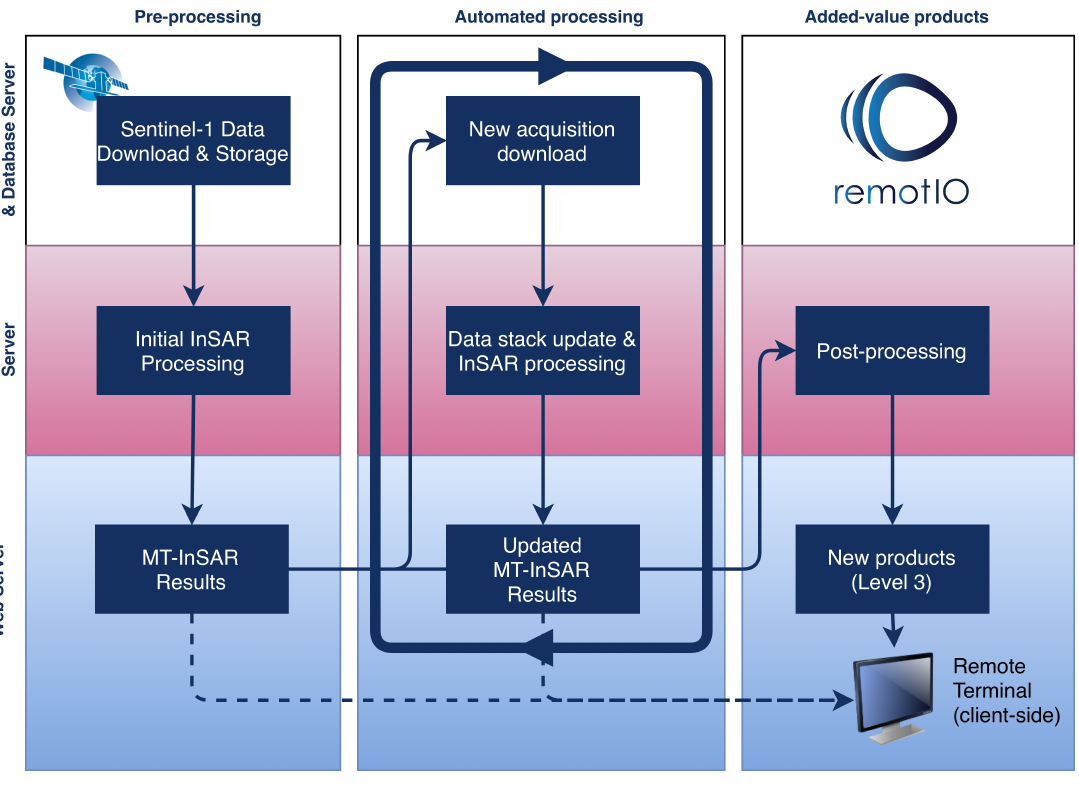
Figure 1. Schematic illustration of remotIO system corresponding to IT